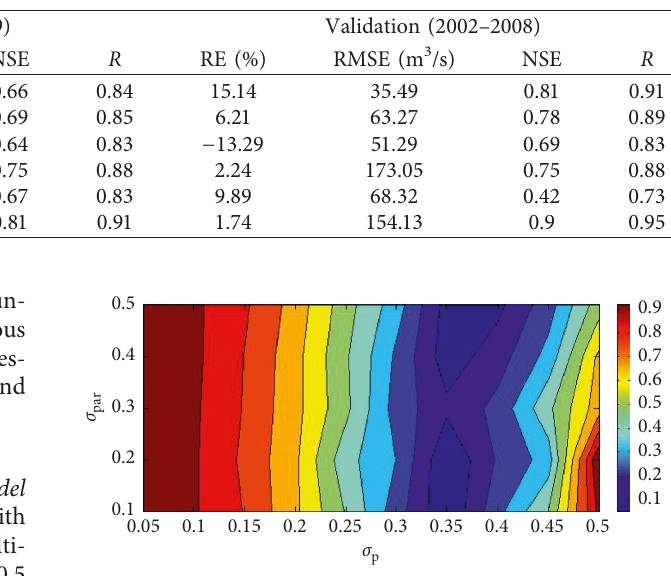
Figure 5: Contour plot of the objective function F (11) with respect to the standard error deviation for precipitation ( σ p ) and for model parameter ( σ par